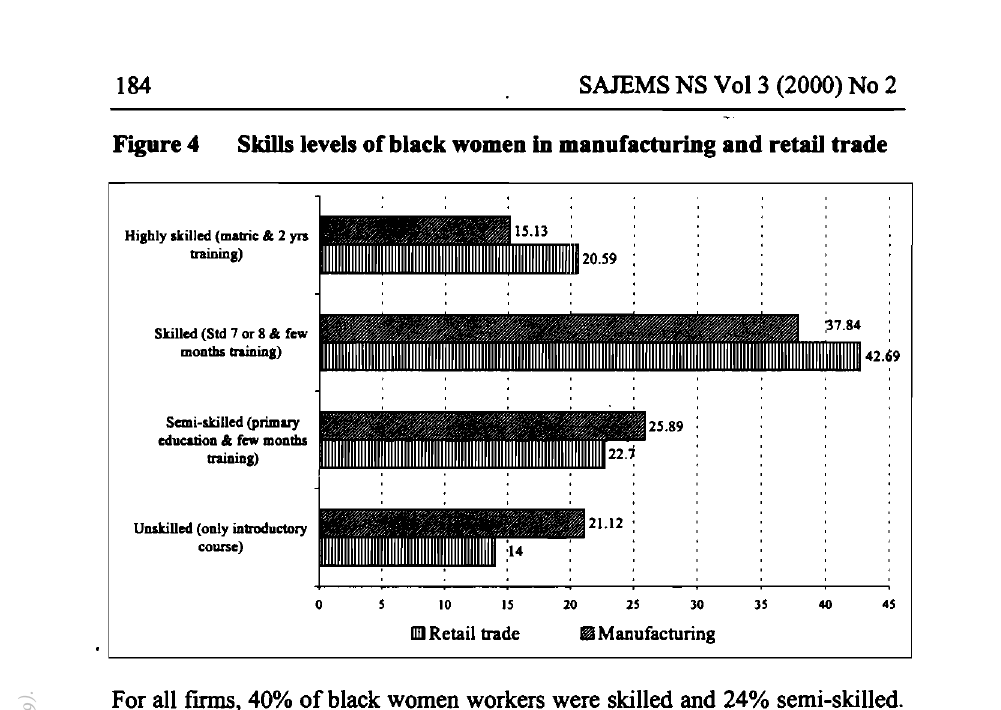
Figure 4 Skills levels of black women in manufacturing and retail trade